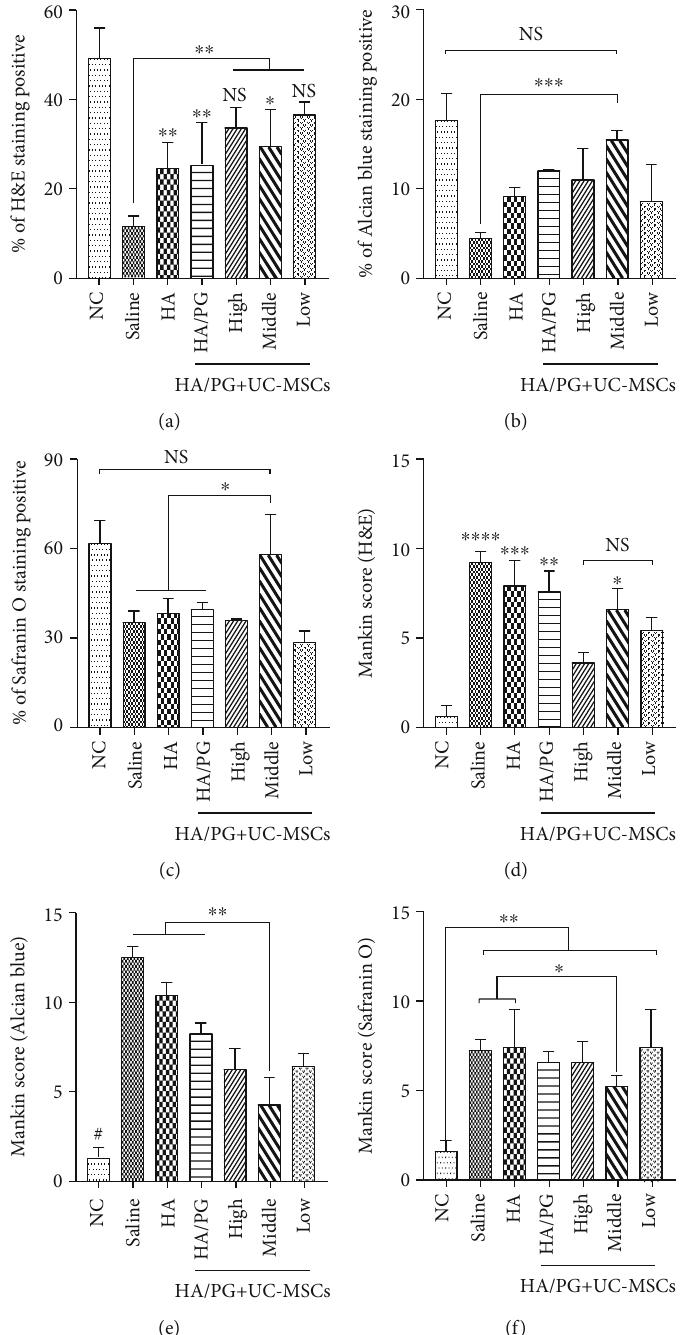
Figure 3: Evaluation of the ameliorative e ff ects of OA rabbits by UC-MSC and/or HA/PG composite treatments. (a – c) Quantitative analysis of the percentage of positive stain area based on H&E staining (a), Alcian blue staining (b), and Safranin-O/fast green staining (c), respectively. All data were shown as mean ± SD ( n = 8 ). ∗ P < 0 : 05 ; ∗∗ P < 0 : 01 ; ∗∗∗ P < 0 : 001 ; NS: not signi fi cant. (d – f) Quantitative analysis of the modi fi ed Mankin scores based on H&E staining (d), Alcian blue staining (e), and Safranin-O/fast green staining (f), respectively. All data were shown as mean ± SD ( n = 8 ). ∗ P < 0 : 05 ; ∗∗ P < 0 : 01 ; ∗∗∗ P < 0 : 001 ; ∗∗∗∗ P < 0 : 0001 ; NS: not signi fi